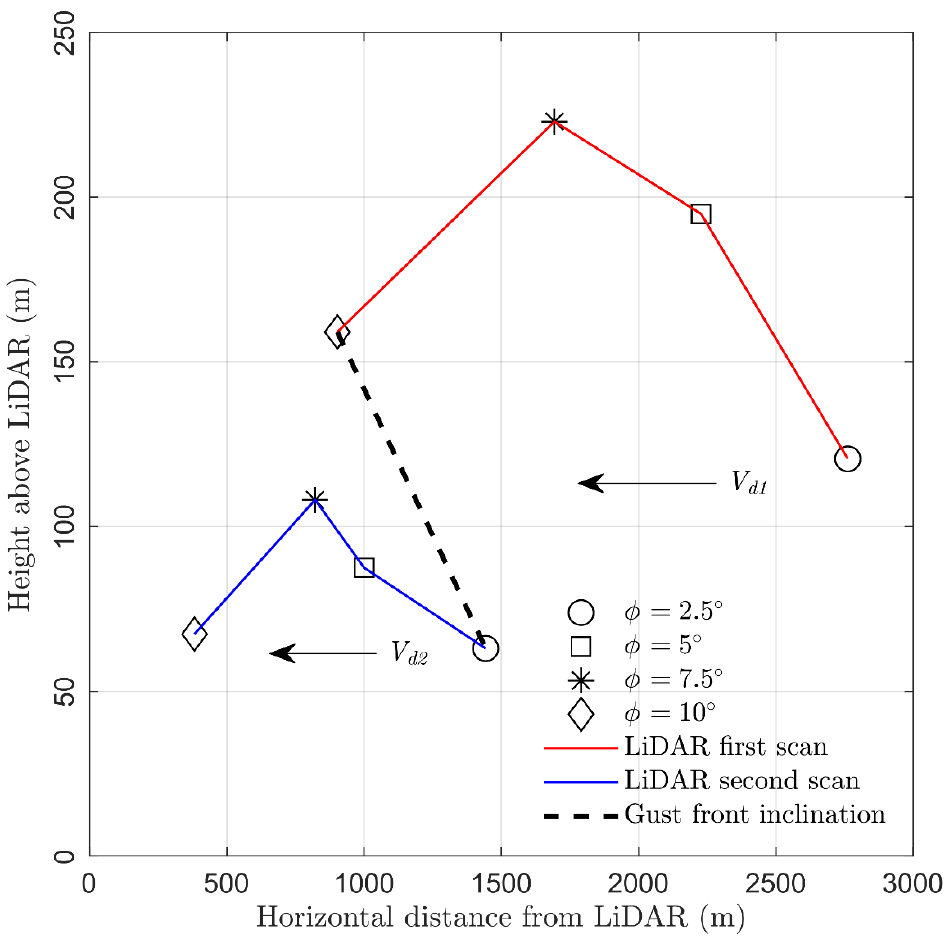
Figure 14. Post-processed lidar data shown the height of gust front at different elevation angles (symbols) and different scanning times (colored lines). Two black arrows show the estimated value of displacement velocity at 115 m ( 𝑉 𝑑1 ) and 65 m ( 𝑉 𝑑2 ) above lidar. The black dotted line depicts the inclination of the gust front head.